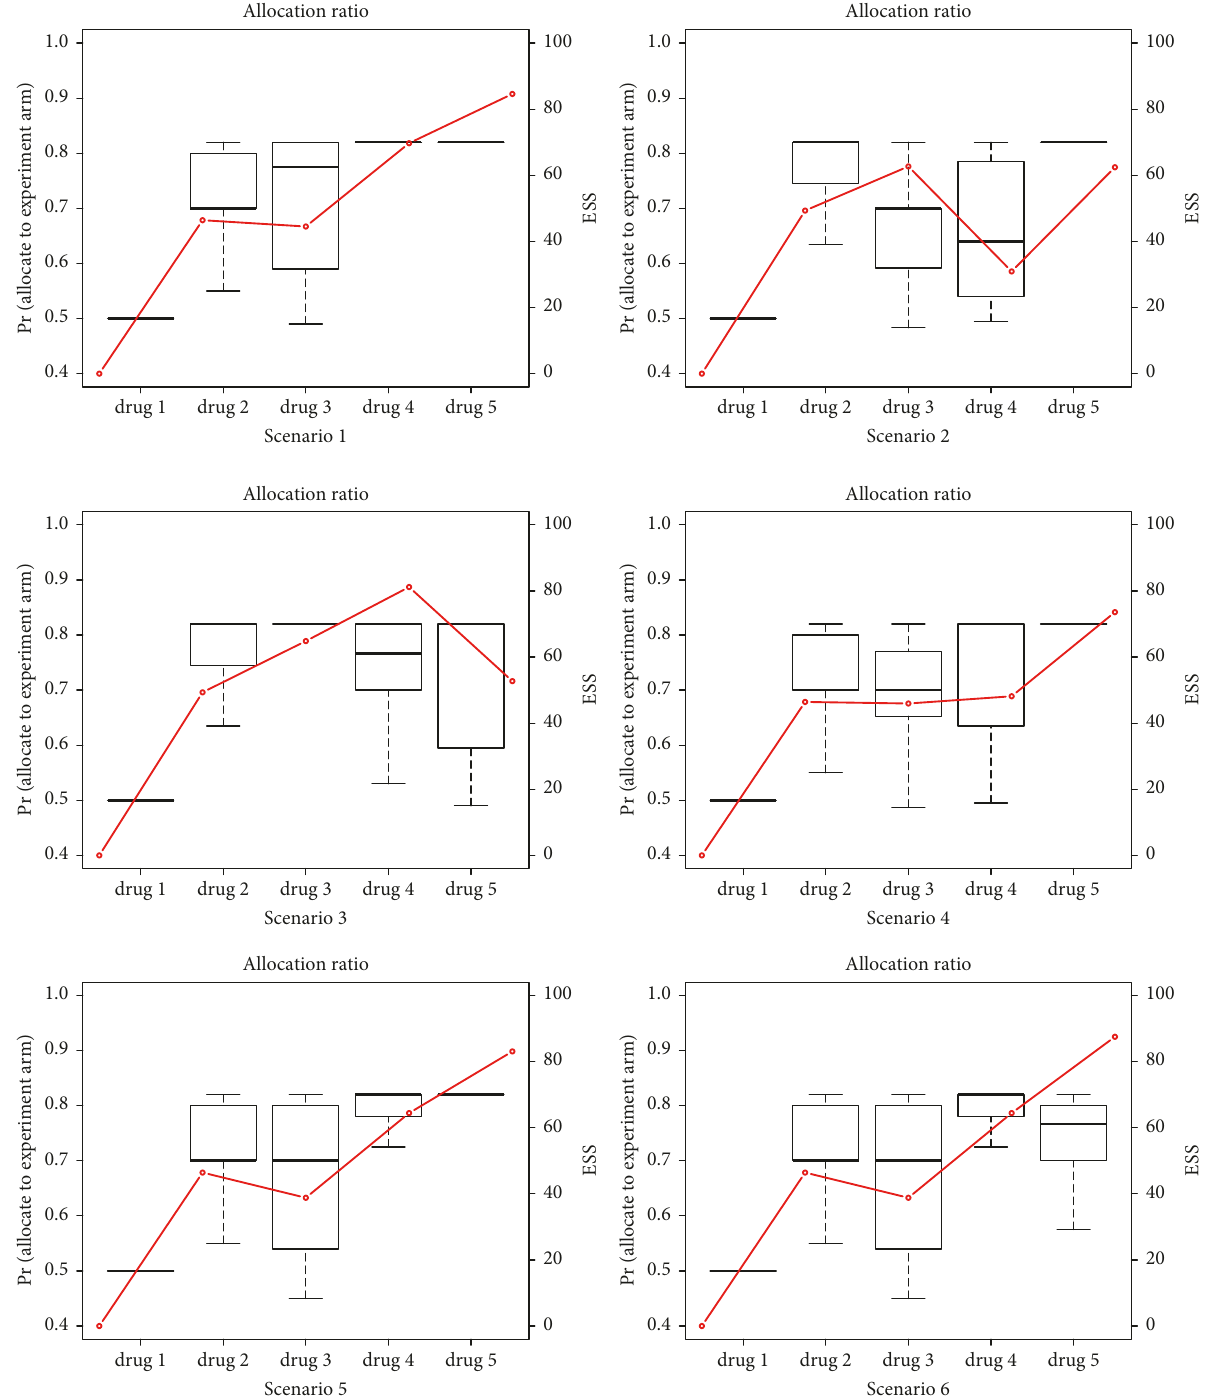
Figure 2: Proportion of patients assigned to the experimental arm and effective sample